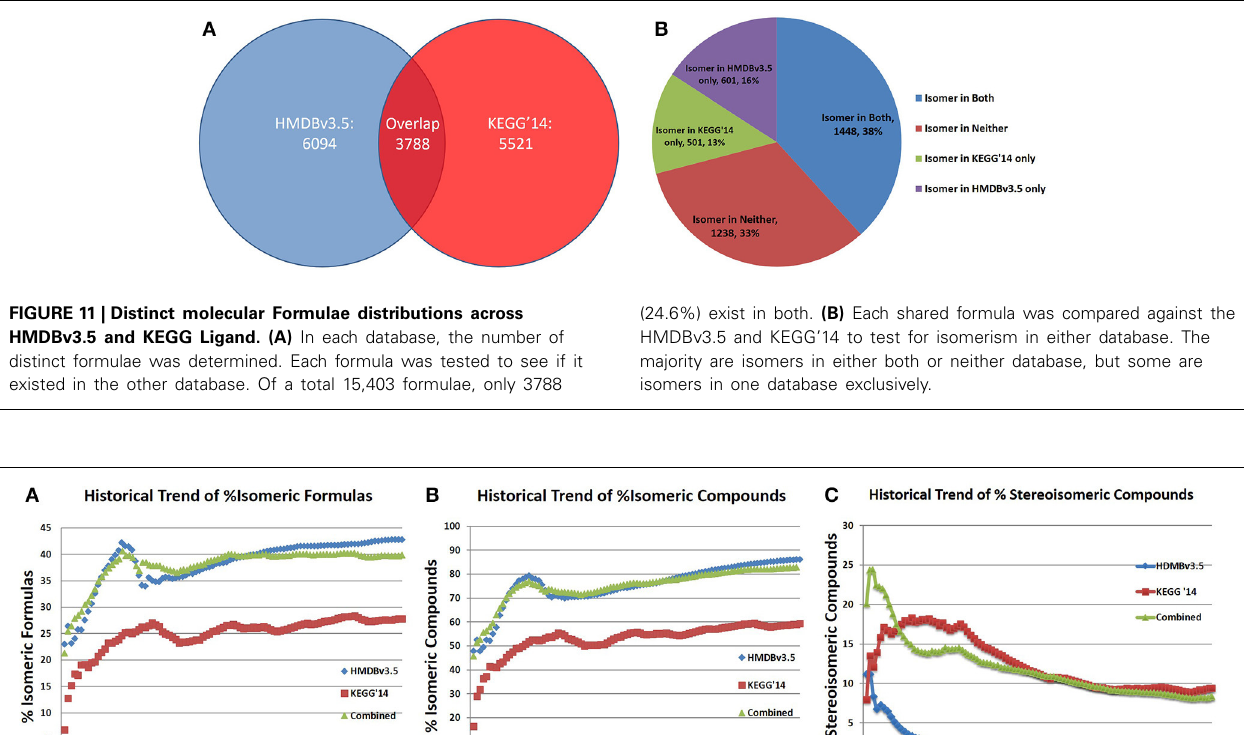
increase with the number of compounds, but both seem to plateau. (C) The combined analysis was performed identically to the individual analysis, but 1% of both databases sorted by ID was added after each trial. The combined analysis reveals that the % isomeric formulae seems to plateau at around 40%, remaining at that level from 55% onwards. (B) In contrast, the % of isomeric compounds in the databases seems to grow at a slow but constant rate for the HMDB, (fits linear with R 2 of 0.9883 after 30%) and a fluctuating but slowly increasing rate for